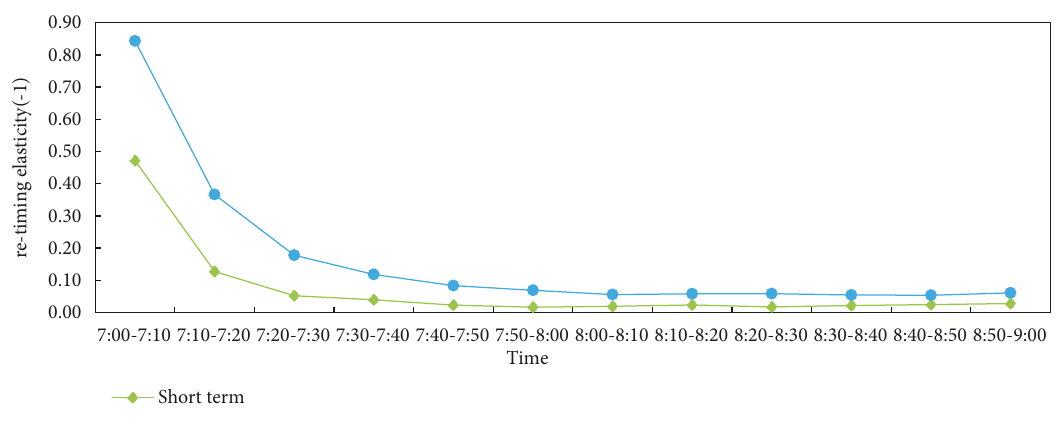
Figure 8: Time-varying retiming elasticities of all